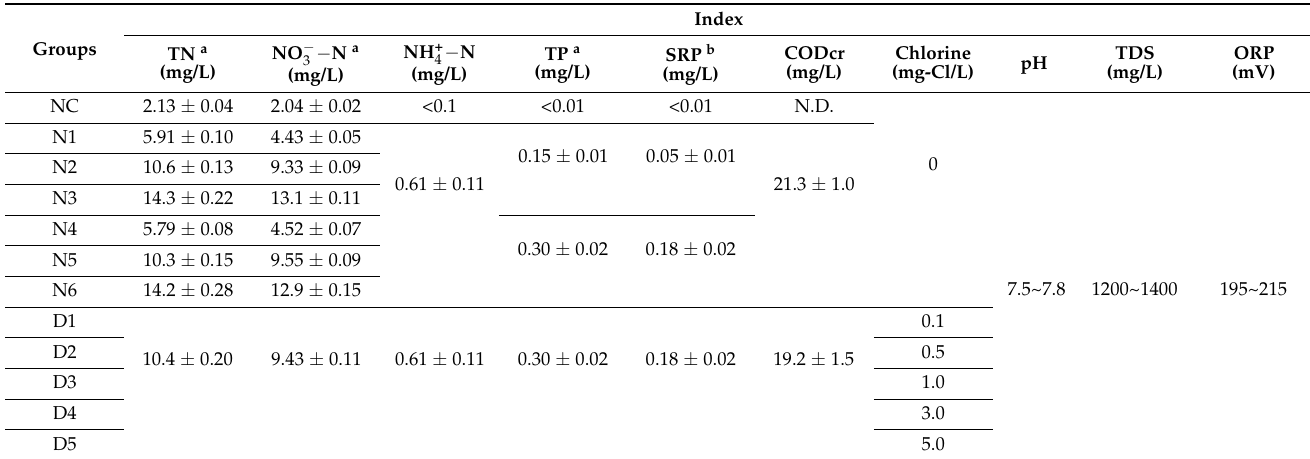
Table 1. The initial conditions and grouping of the experiments.